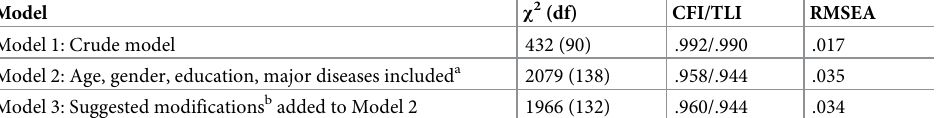
Table 4. Model fit statistics on the bidirectional longitudinal association between health behavior and subjective well-being. Model χ 2 (df) RMSEA Model 2: Age, gender, education, major diseases included